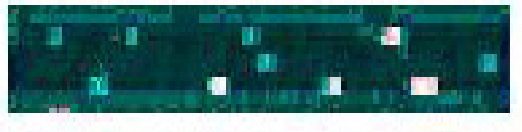
Figure 19: Resultant Vehicle Detected